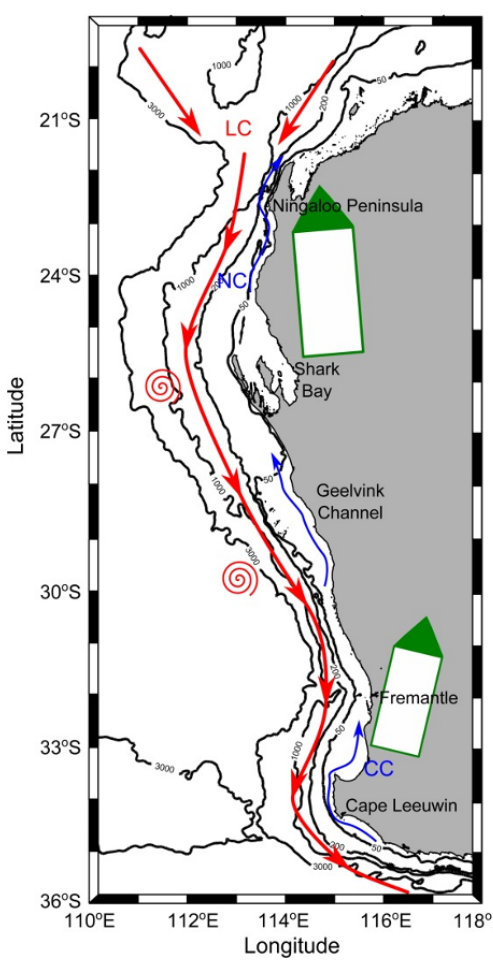
Figure 21. Map of the Western Australian coast with thin black con- tours showing the 50, 200, 1000, and 3000m isobaths. Green arrows represent mean surface winds; red arrows indicate the Leeuwin Cur- rent; red schematic vortices indicate mesoscale eddies, and blue ar- rows indicate the Capes and Ningaloo currents (from Rossi et al.,